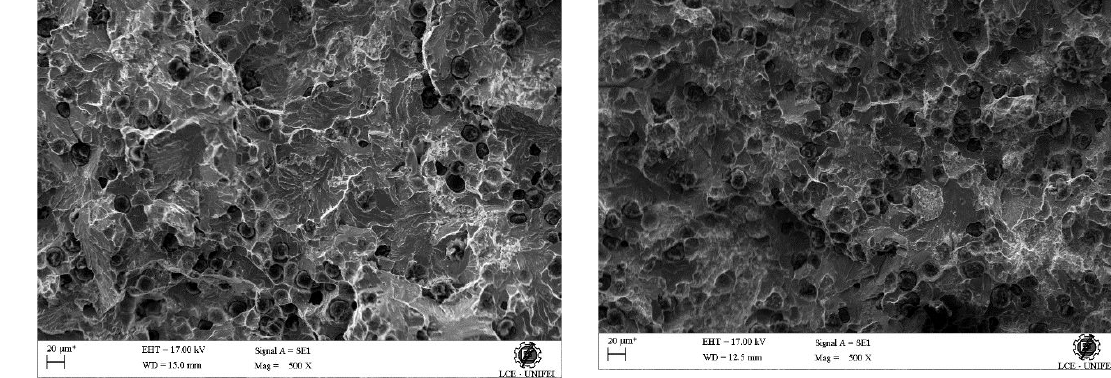
Figure 31. Fractured surface of Ni/Cu.